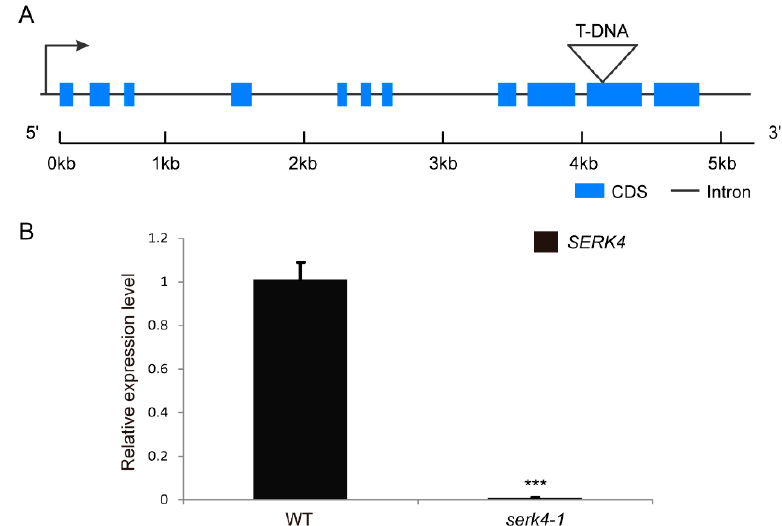
Figure 3. Expression of SERK4 in the T-DNA insertion line: ( A ) the exon/intron structure of the SERK4 gene and location of the T-DNA insertion; ( B ) the expression level of SERK4 revealed by qRT-PCR in LS leaves of wildtype and the T-DNA insertion line, the ratios of SERK4 gene expression level were calculated relative to the wildtype leaf. CDS, coding sequence; WT, wildtype. The expression data are means ± SD of three biological repeats. *** p < 0.001 ( t -tests).